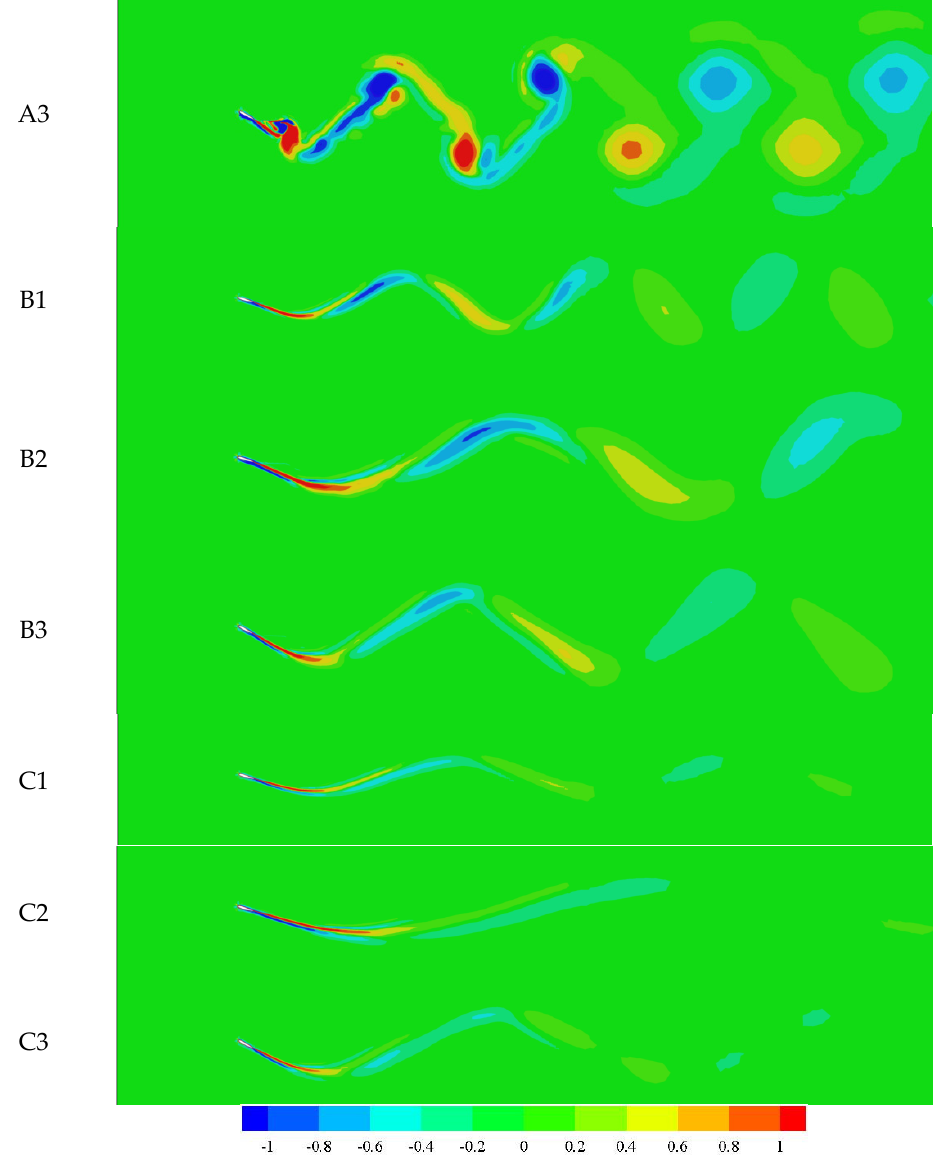
Figure 22. Vorticity distribution at nine analysis points. Colors represent positive (red) and negative (blue) vorticity. ( A1 )–( C3 ) represent nine analysis points which are shown in Figure 21.